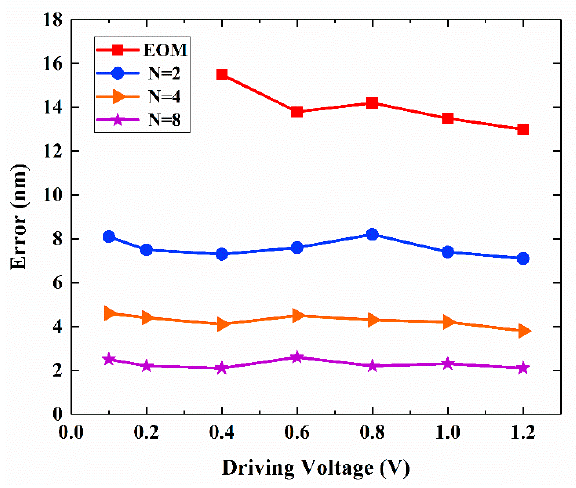
Figure 9. Experimental errors of the proposed MR-PM and EOM-PM with different driving volt- ages.